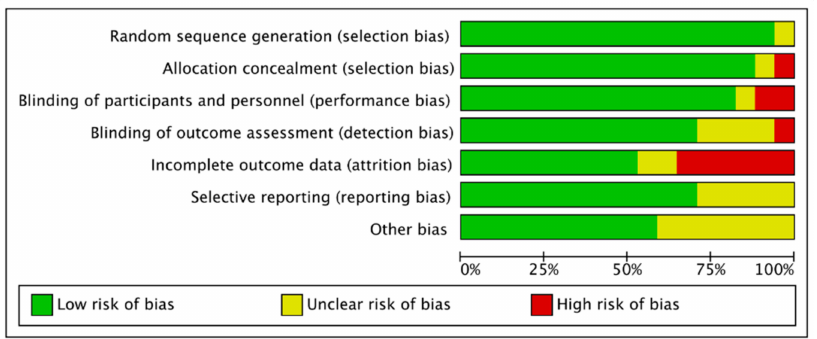
Figure 1. Risk of bias graph: judgements for risk of bias items presented as percentages across all included studies.